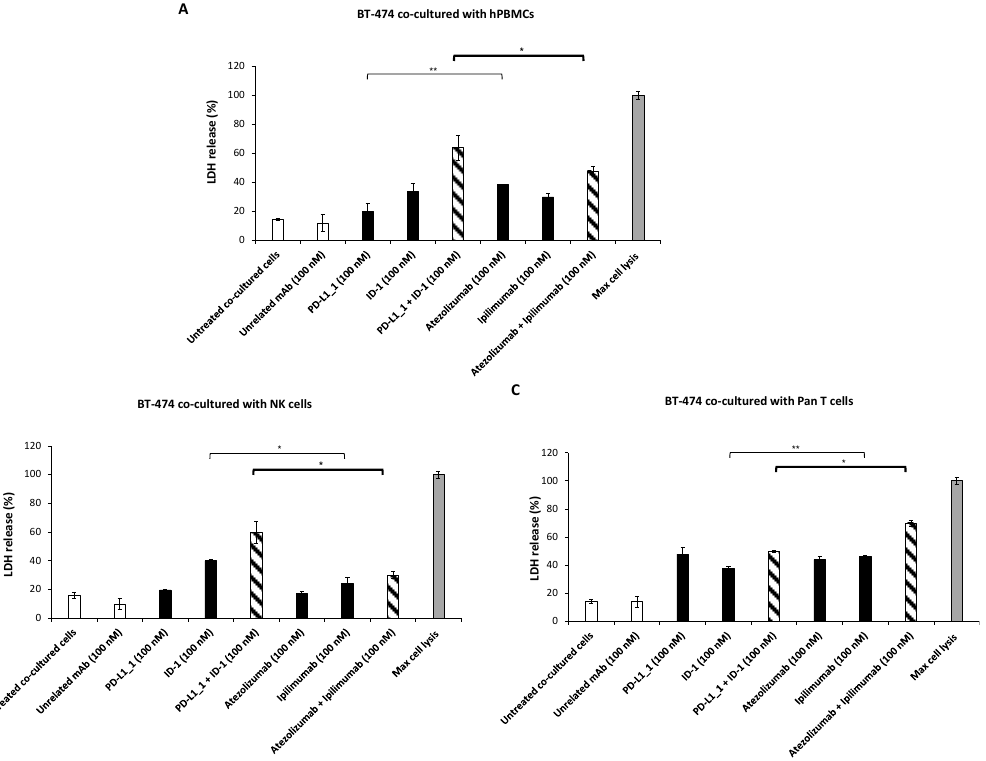
Figure 3. Cytotoxic effects of immunomodulatory mAbs on non-TNBC cells co-cultured with total hPBMCs or its derived NK and T cells subpopulations. Cells were cultured with the indicated immune cells in the absence or presence of the novel immunomodulatory mAbs, used alone (black bars) or in combination (striped bars) at the indicated concentrations for 48 h. The clinically validated atezolizumab and ipilimumab were used for comparison in parallel assays. Untreated cells or cells treated with an unrelated mAb were used as negative controls (white bars). After treatment, the release of LDH was measured by collecting the supernatants from the tumor cells co-cultured with total hPBMCs ( A ), NK ( B ) or Pan T-enriched populations ( C ). The tumor cell lysis was expressed as %, with respect to the 100% of lysis (grey bars) obtained by incubating the cells with 10% Triton X100. Cell lysis values were reported as the mean of at least three determinations obtained in three independent experiments. Error bars depict means ± SD. P-values were calculated by comparing each treatment with untreated co-cultured cells or comparing the two combinations with each other and reported as ** p < 0.01; * p < 0.05.